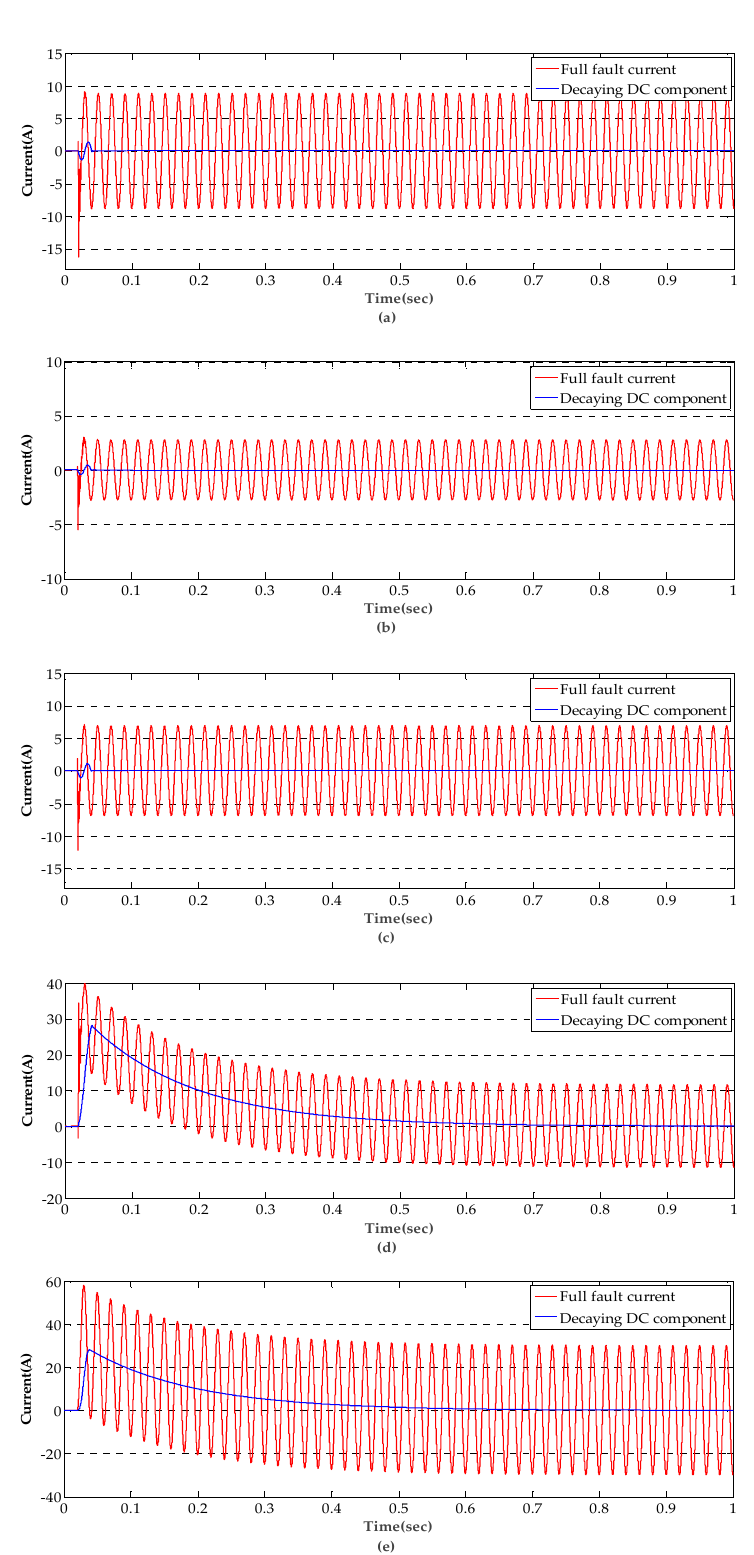
Figure 6. The results of the full fault current and the decaying DC component in zero ‐ sequence of the lines and the anti ‐ arc coil. ( a ) The results of the non ‐ fault line L 1 ; ( b ) The results of the non ‐ fault line L 2 ; ( c ) The results of the non ‐ fault line L 3 ; ( d ) The results of the fault line L 4 ; ( e ) The results of the anti ‐ arc coil.